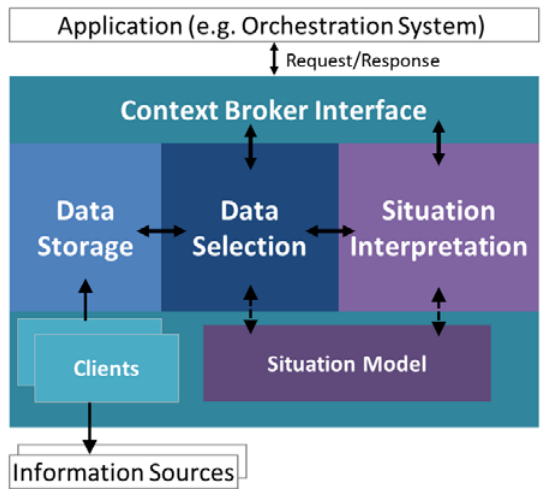
Figure 6. Structure of Context Broker used by orchestration